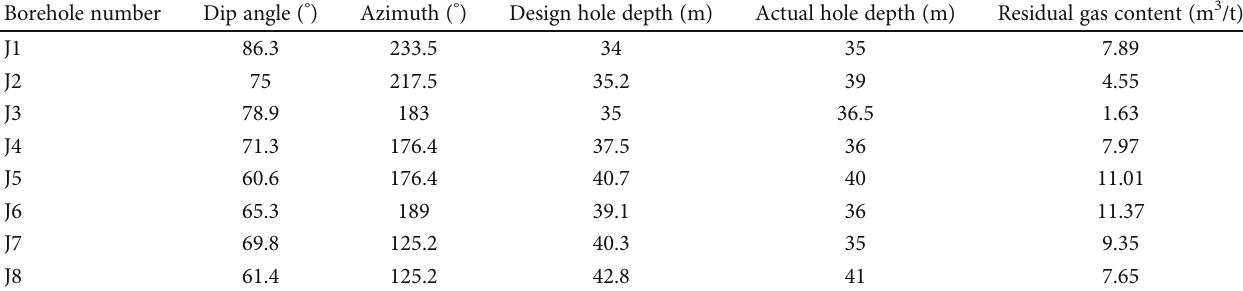
Table 4: Statistical table of drilling construction and residual gas content. Borehole